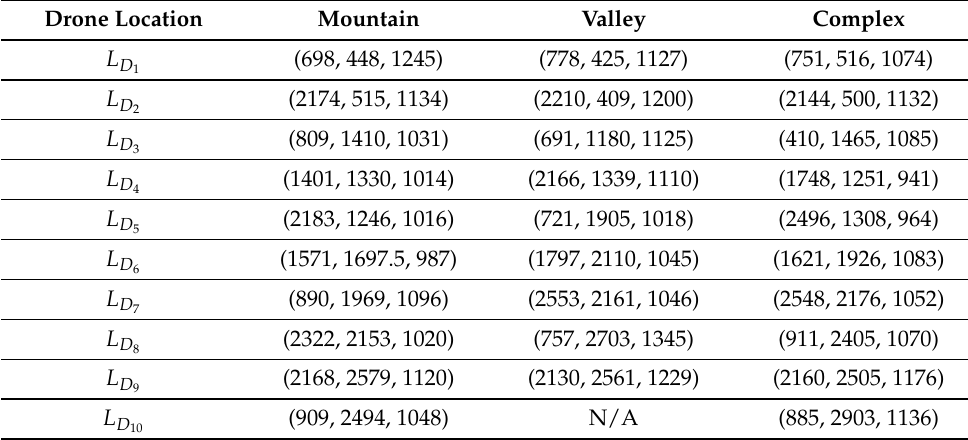
Table 2. The drone fleet’s locations of three different topographies.